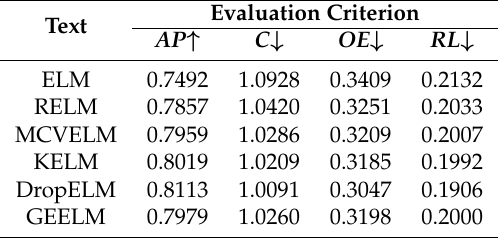
Table 7. The effectiveness comparison of ELM and its variants on the Text